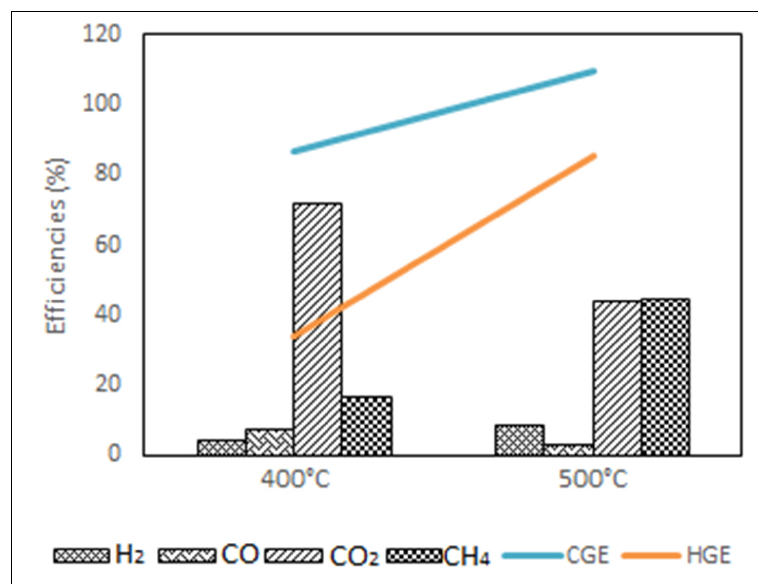
Figure 15. In fl uence of temperature on gas composition and process e ffi ciencies . Figure 15. Influence of temperature on gas composition and process